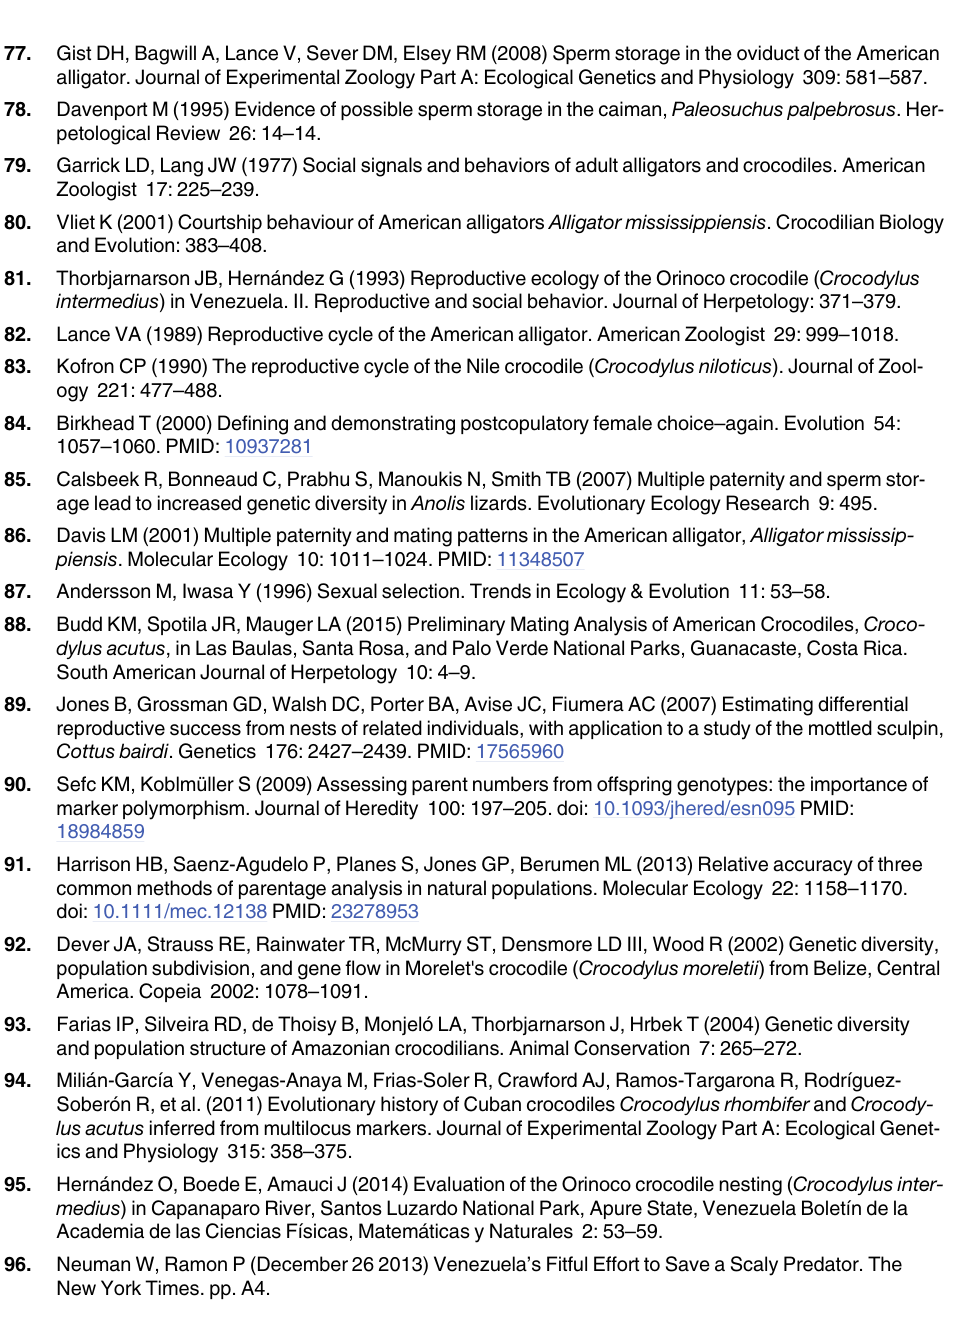
PLOS ONE | DOI:10.1371/journal.pone.0150245 March 16,